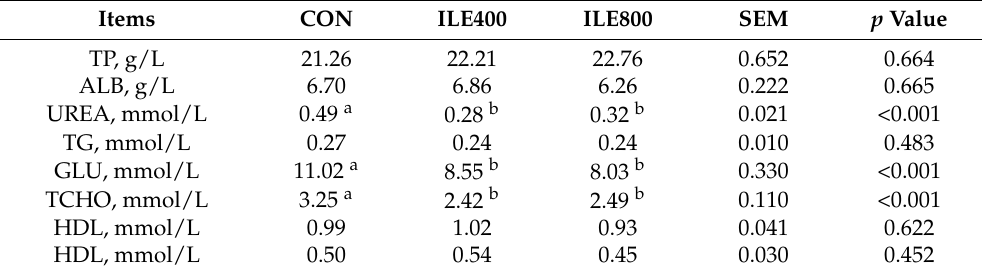
Table 4. The effect of dietary supplementation with isoleucine (Ile) on the serum biochemistry of broiler chickens.